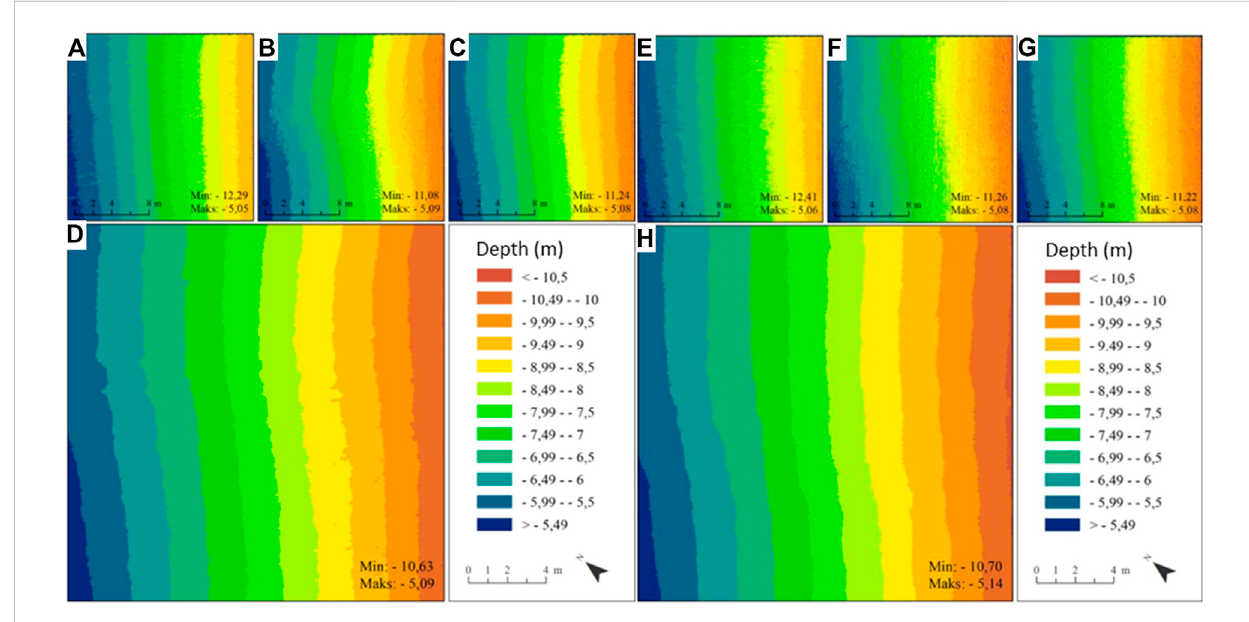
FIGURE 9 (A) Un fi lteredDBMfromscenarioA; (B) un fi lteredDBMfromscenarioB; (C) un fi lteredDBMofAandBscenario; (D) fi lteredDBMofAandBscenario;